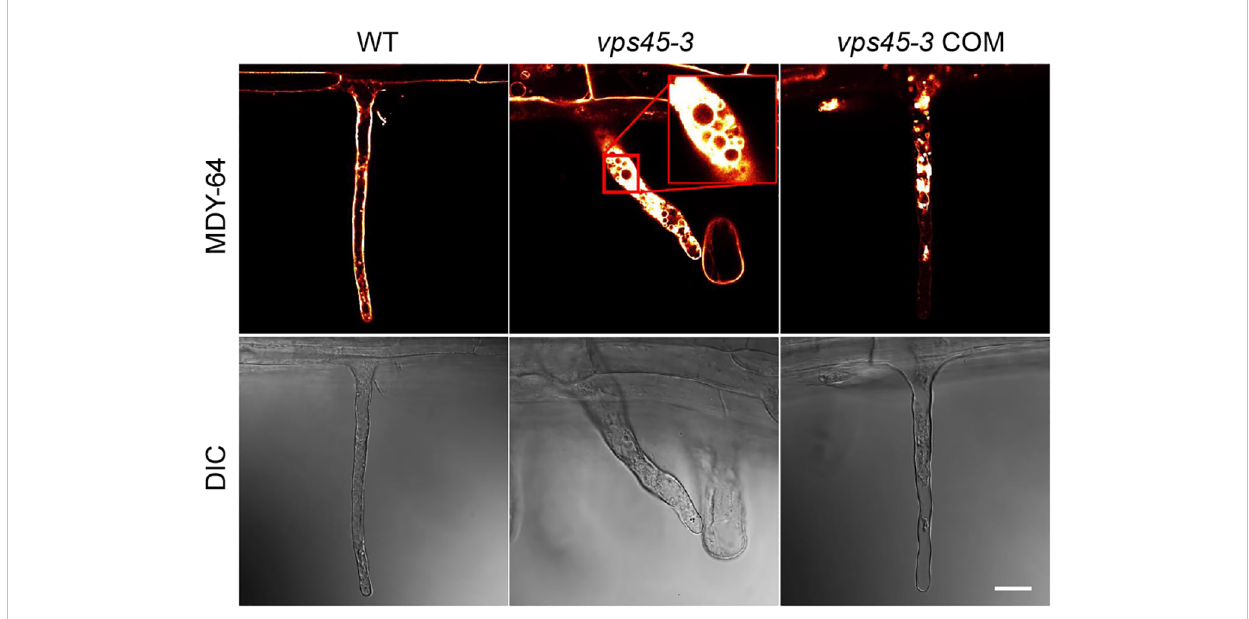
FIGURE 6 vps45-3 seedling root hairs show vacuole defects. Root hairs from 5-day-old seedlings were treated with the tonoplast membrane stain MDY-64 and imaged using confocal microscopy. Scale bar = 20 m m, DIC indicates differential interference contrast